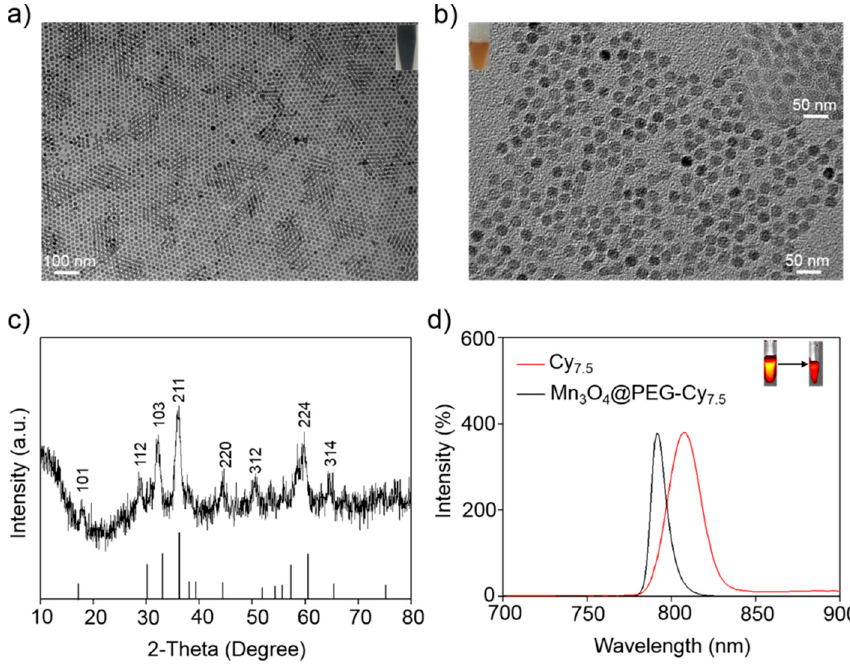
Figure 1. Characterization of Mn 3 O 4 @PEG NPs. ( a ) TEM images of Mn 3 O 4 NPs; ( b ) TEM images of Mn 3 O 4 @PEG NPs and Mn 3 O 4 @PEG-Cy 7.5 NPs (Inset); ( c ) X-ray diffraction pattern of Mn 3 O 4 NPs; ( d ) The fluorescence imaging (FI) spectrum of Cy 7.5 (red line) and Mn 3 O 4 @PEG-Cy 7.5 (black